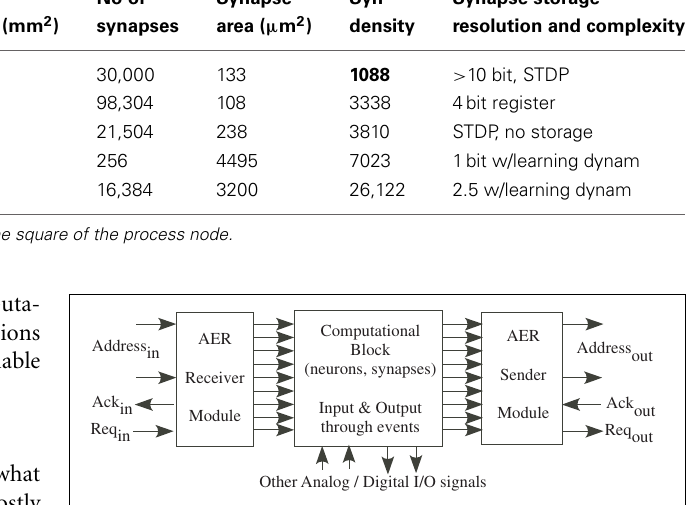
Table 1 | Comparison of synapse density and function of working implementations. Chip built